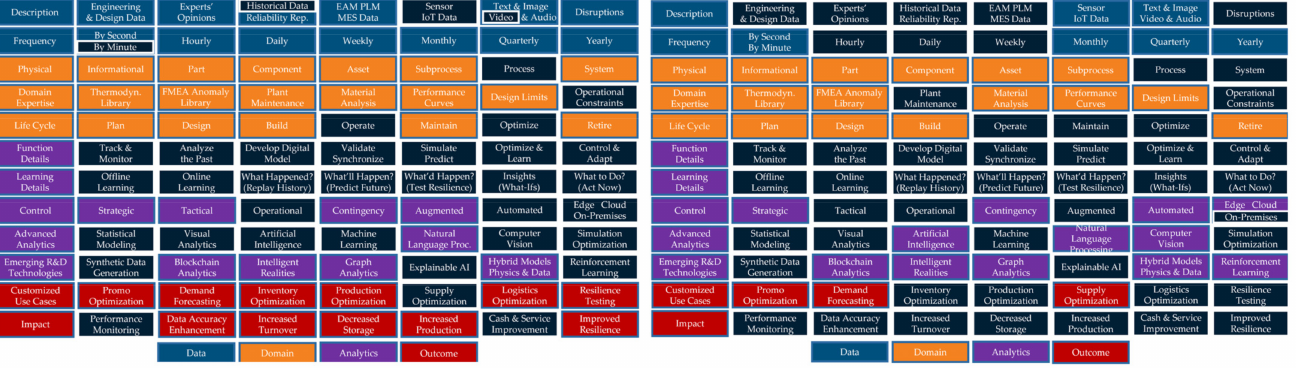
Figure 3. A factory digital twin (on the left-hand side) and a supply chain digital twin (on the right-hand side).